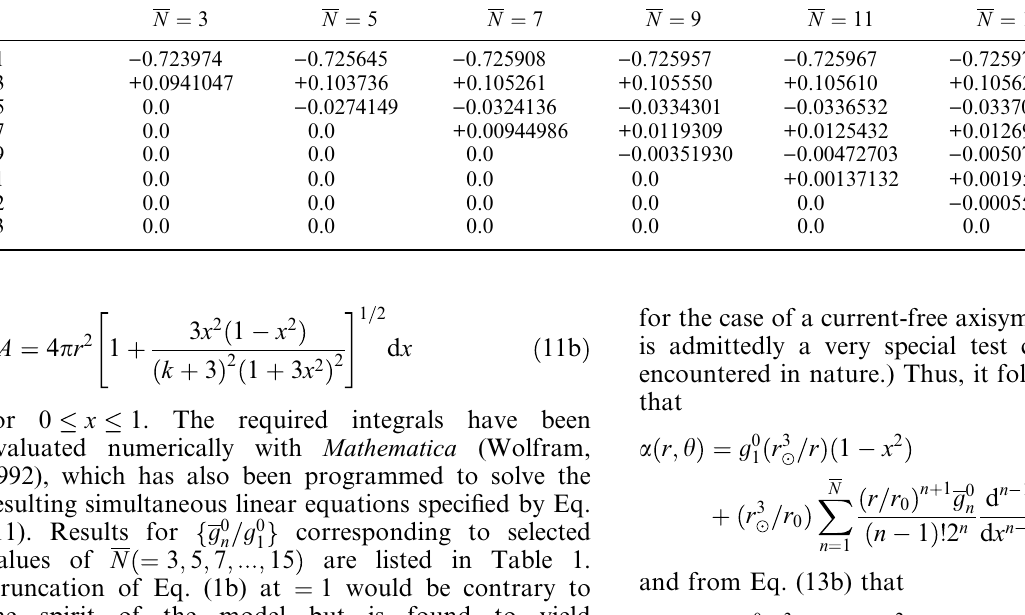
Table 1. Optimized values of g 0